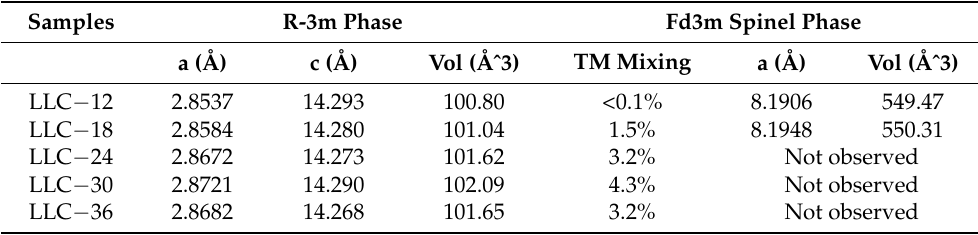
Figure 1. X-ray Diffraction patterns for all the LLCs powder samples ( a ) 2 Ɵ : 10–80° and ( b ) 2 Ɵ : 30– 50°. Table 1. Unit cell parameters of as-prepared LMR samples.